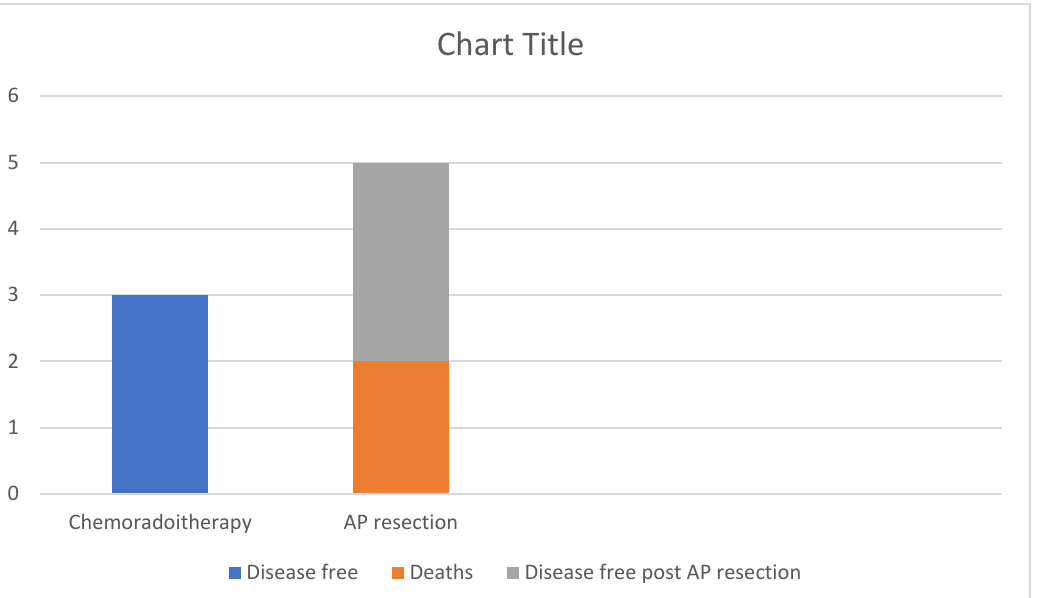
Figure 6. Grades of dysplasia in the histopathology results of the cohort, ranging from CA without dysplastic/neoplastic features to invasive SCC. A total of 19 patients (54.7%) had dysplastic and malignant features in their samples ranging from mild (5 patients) and high (4 patients) grade Figure 7. Outcomes of the patients with invasive SCC. 50% remain disease free after chemoradio- dysplasia to confirmed SCC (10 patients), illustrating the prevalence of malignant transformation in therapy alone, while of the 50% that required AP resection after relapse 60% remain disease free at the context of CA and the importance of follow up. 5 years post-operatively and 40% died.